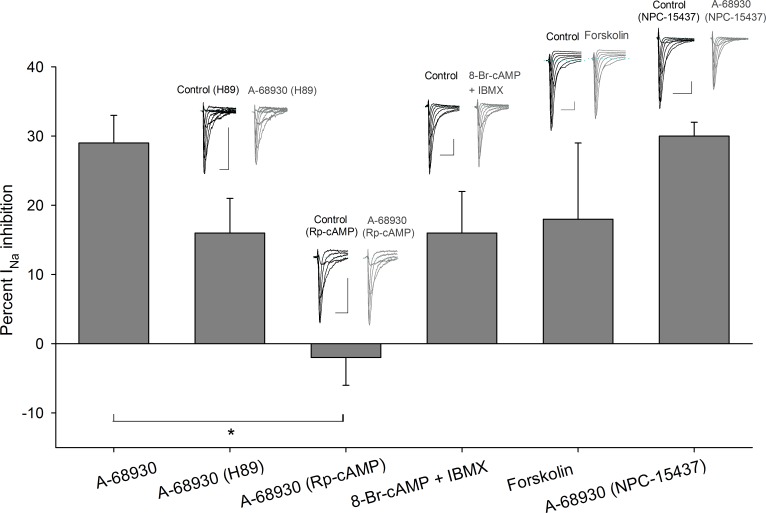
Transducer mechanisms activated by D1-like receptors.Bars show the effect of A-68930 in control condition in comparison with its action while other drugs were used. The use of H89 in the intracellular solution decreased the inhibitory effect of A-68930 from 29 ± 4% to 16 ± 5% at −10 mV (P = 0.08). When cells were preincubated with 50 μM Rp-cAMP, A-68930 effect was completely blocked (P < 0.001). Coapplication of 8-Br-cAMP and IBMX mixture caused a decrease in the INa current which mimicked the effect of A-68930 (P = 0.114). Forskolin also mimicked the effect of D1-like agonist decreasing the INa 18 ± 11% (P = 0.27). The NPC-15437 in the intracellular solution did not significantly modify the A-68930 effect (P = 0.92). Insets above bars show typical recordings of the INa under control conditions and after drug application. Calibration bars are 2 ms and 0.5 nA for all recordings.